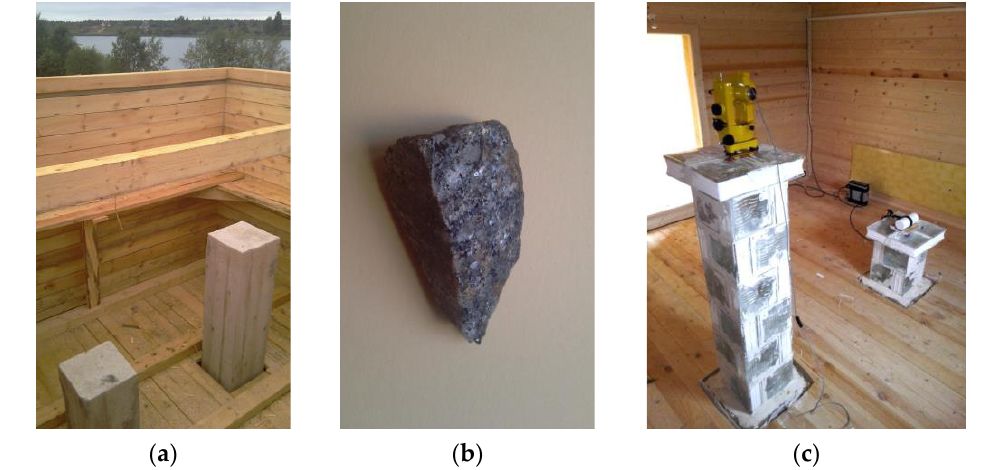
Figure 1. Klimovskaya magnetic observatory: ( a ) Absolute pavilion construction site and initially designed observation pillars; ( b ) a specimen of crushed diorite stone from the construction site; ( c ) Reconstructed pillars in the finalized absolute pavilion.